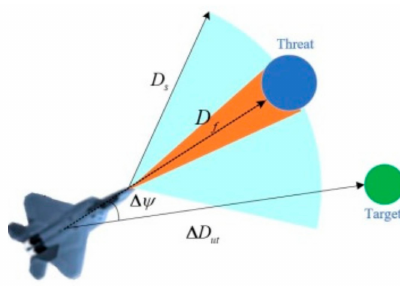
Figure 3. Relative situations among UAV, threats, and